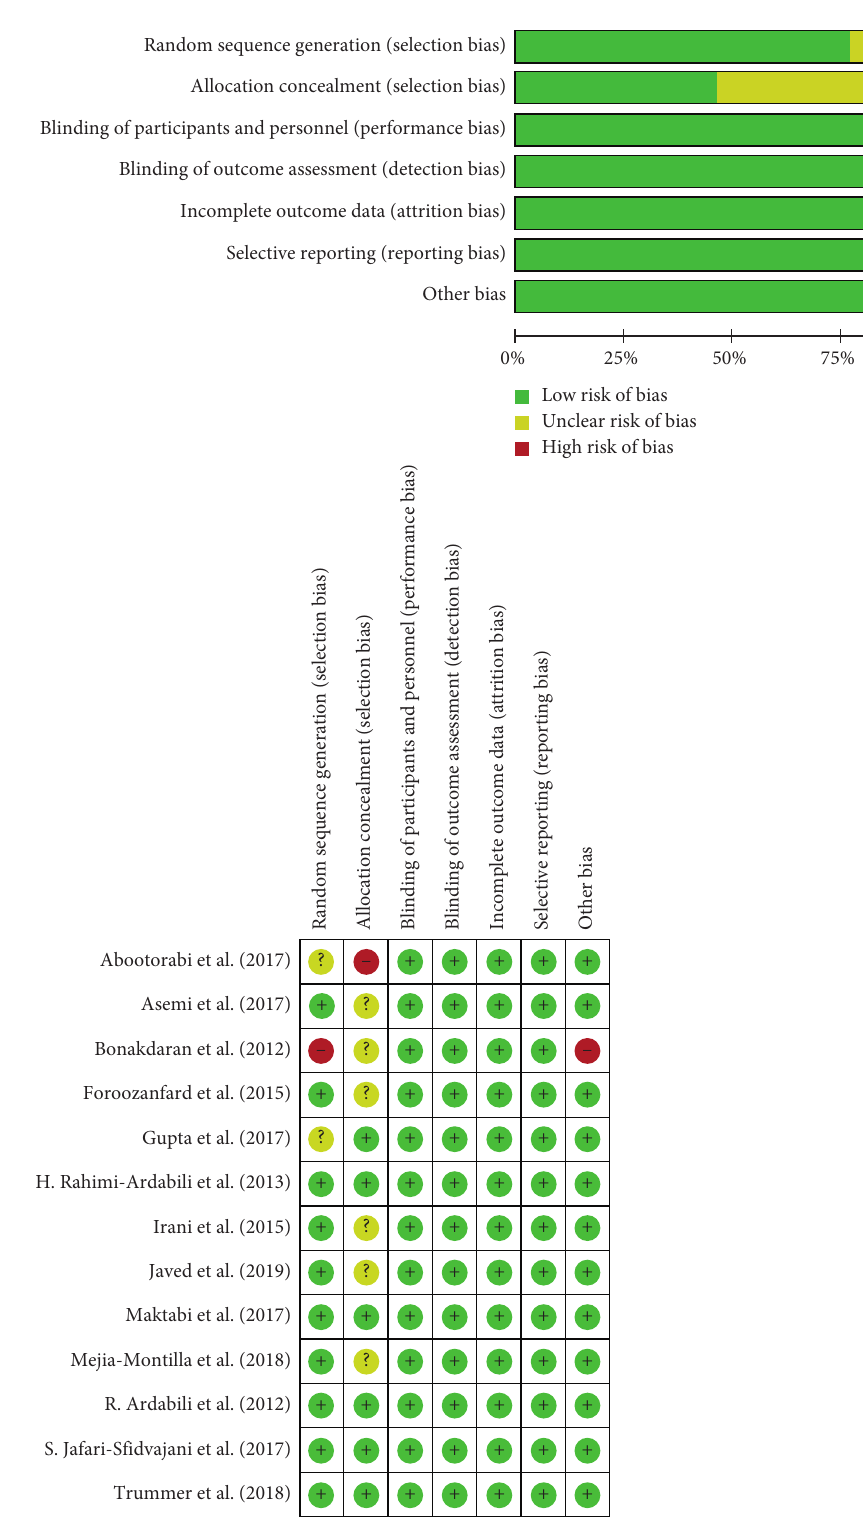
Figure 2: Quality assessment for randomized controlled trials included on basis of Cochrane risk of bias assessment